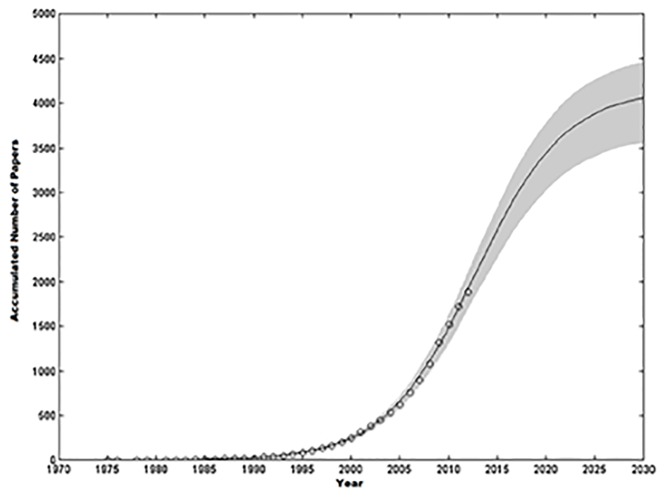
Growth Trend of the DQ Literature [4].